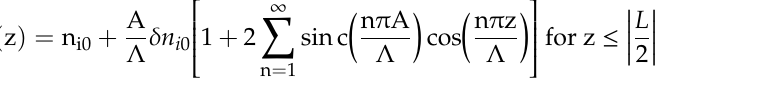
Table 1. Laminated plates constructed: Length and average values.